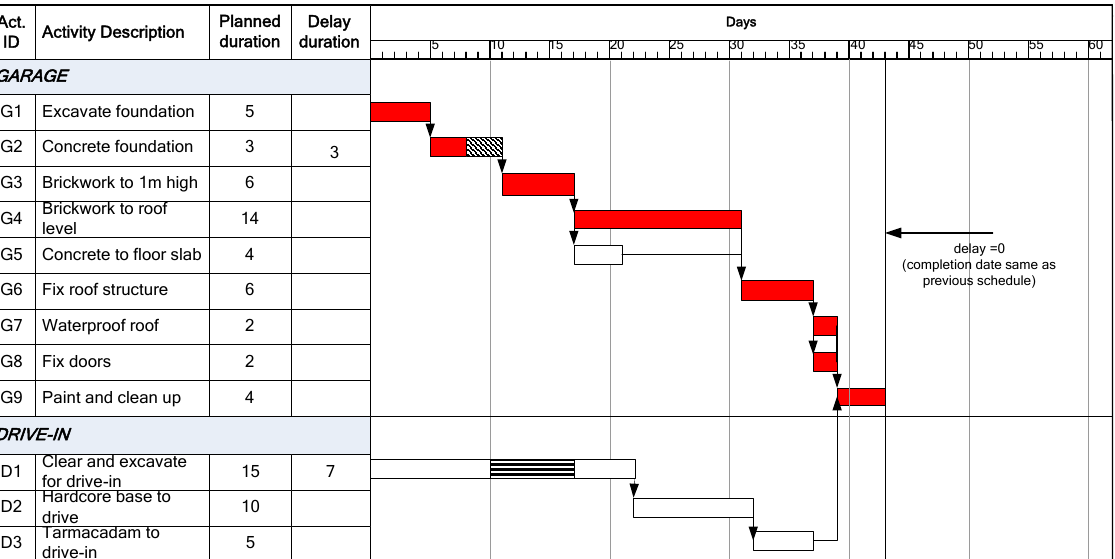
Figure 6. Impact of second